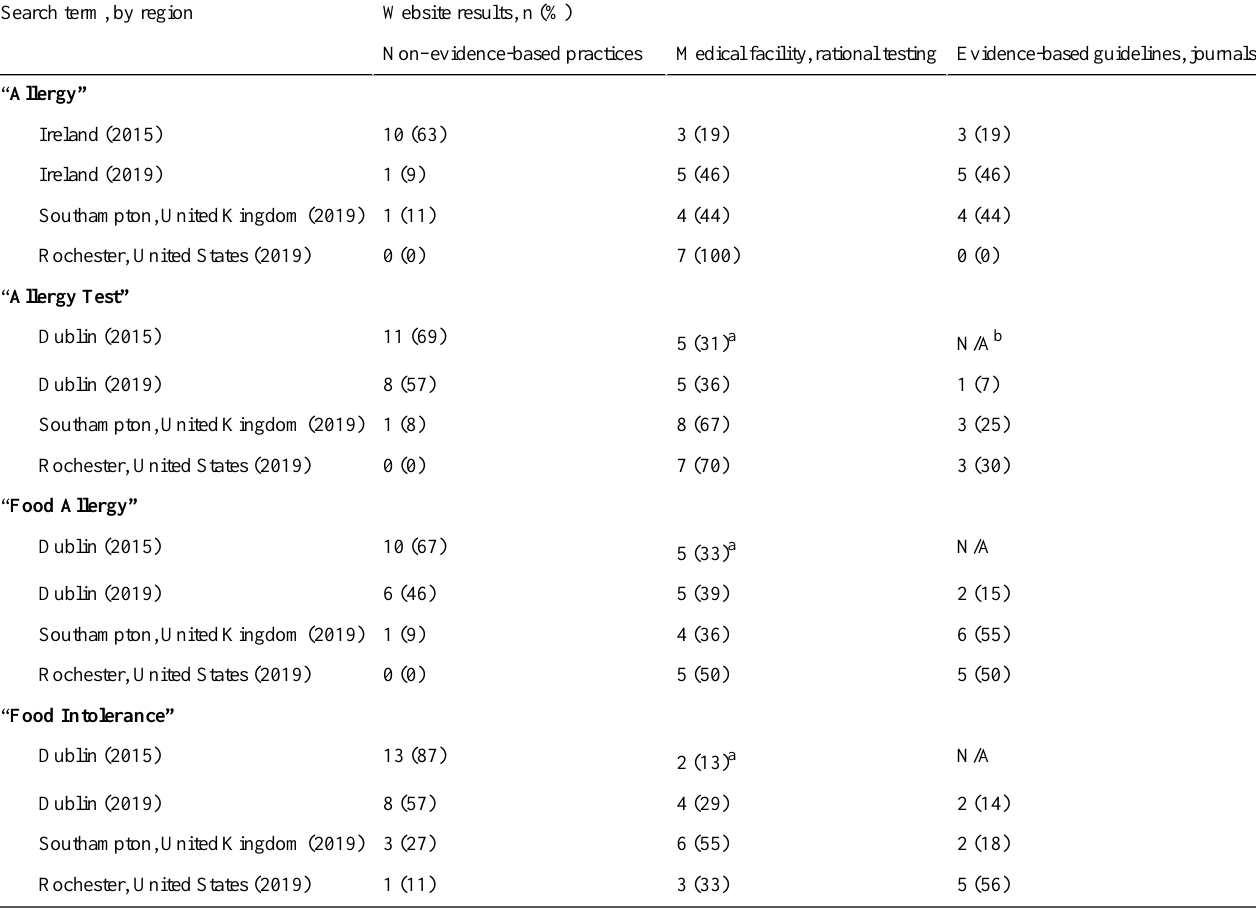
Table 2. Summary of results of localized internet searches for the specified allergy-related search terms.